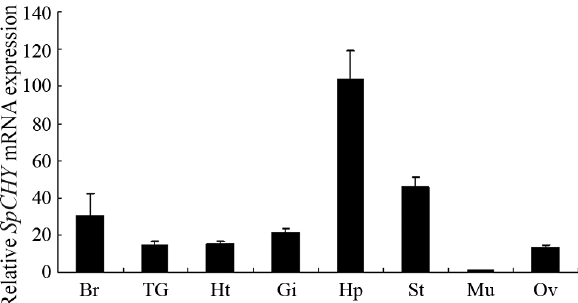
Figure 4 - The results of quantitative real-time PCR analysis of SpCHY expression in various tissues. Expression of a (cid:3) -actin gene was used as control. Values were shown as means (cid:5) S.E. (N = 3). Abbreviations: Br, brain; TG, thoracic ganglion; Ht, heart; Gi, gill; Hp, hepatopancreas; St, stomach; Mu, muscle; Ov,